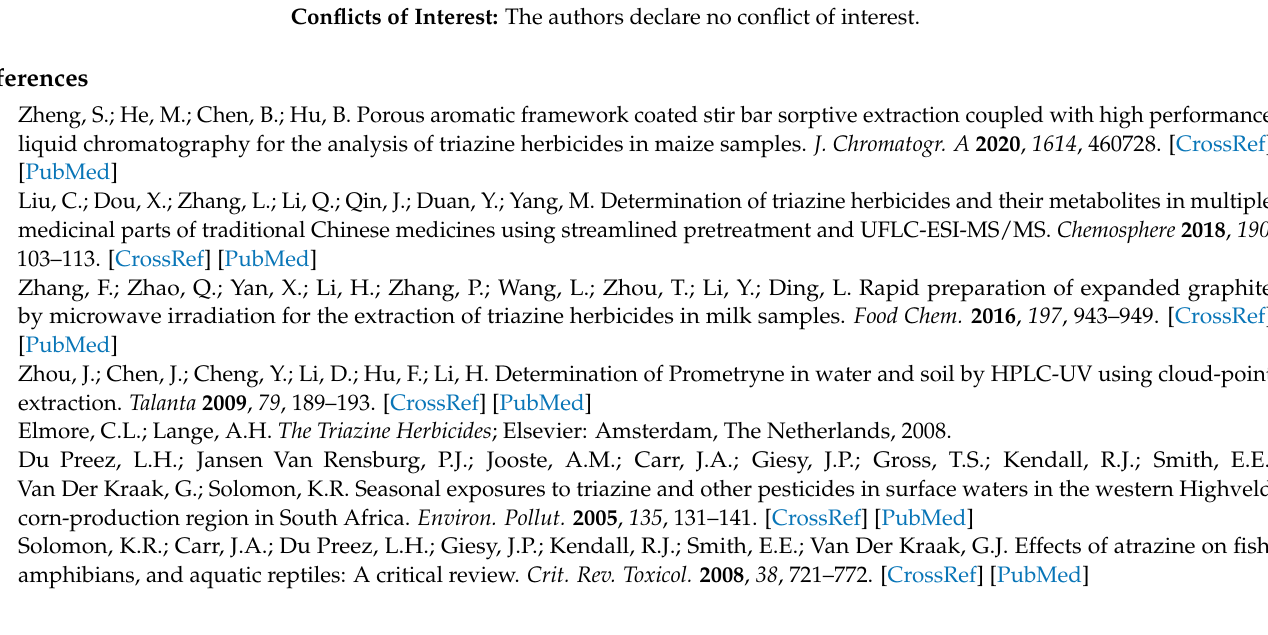
effluent. Table S1. Characteristics of wastewater in different units. Table S2. Comparison of the individual herbicide concentrations in